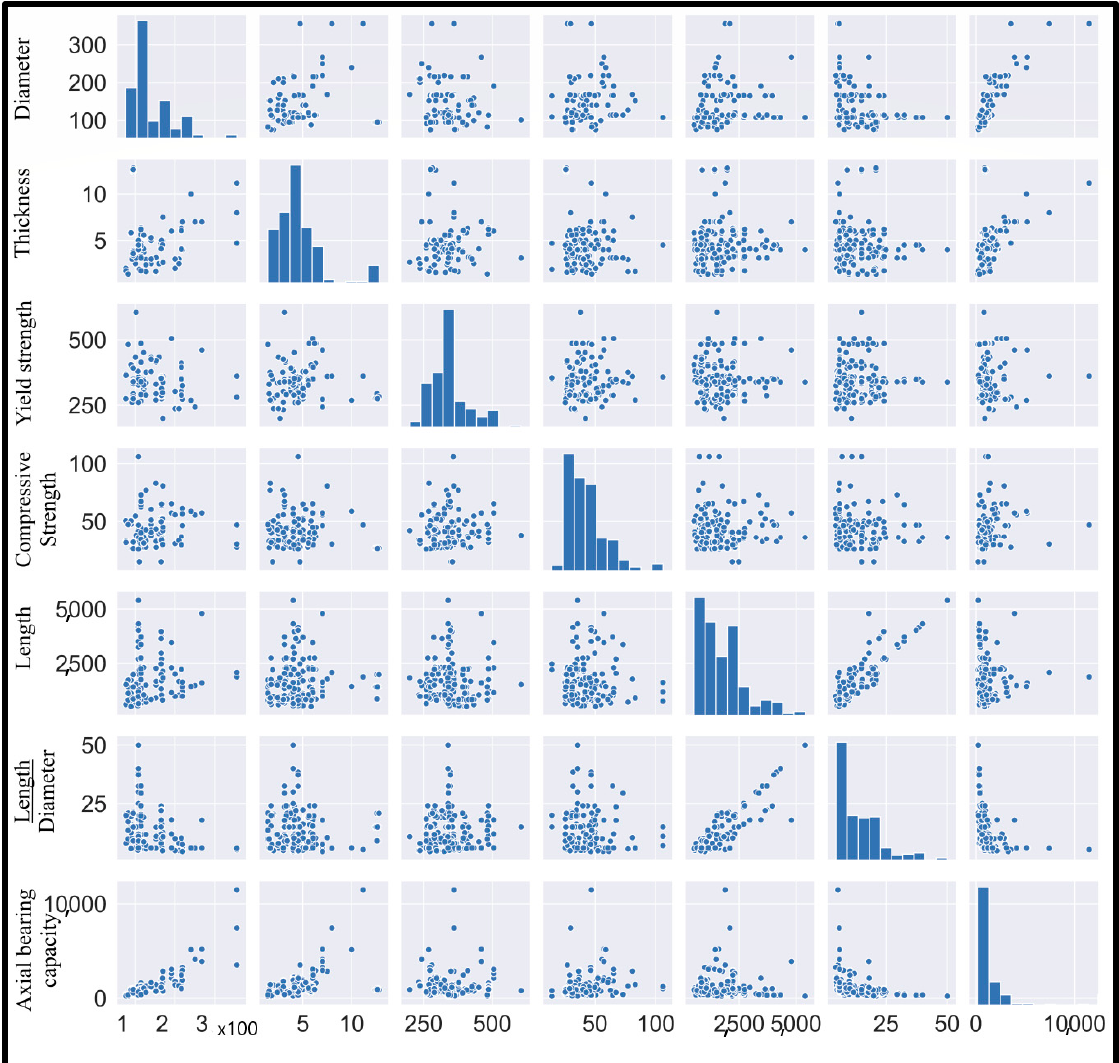
Figure 3. Relationship among individual variables.